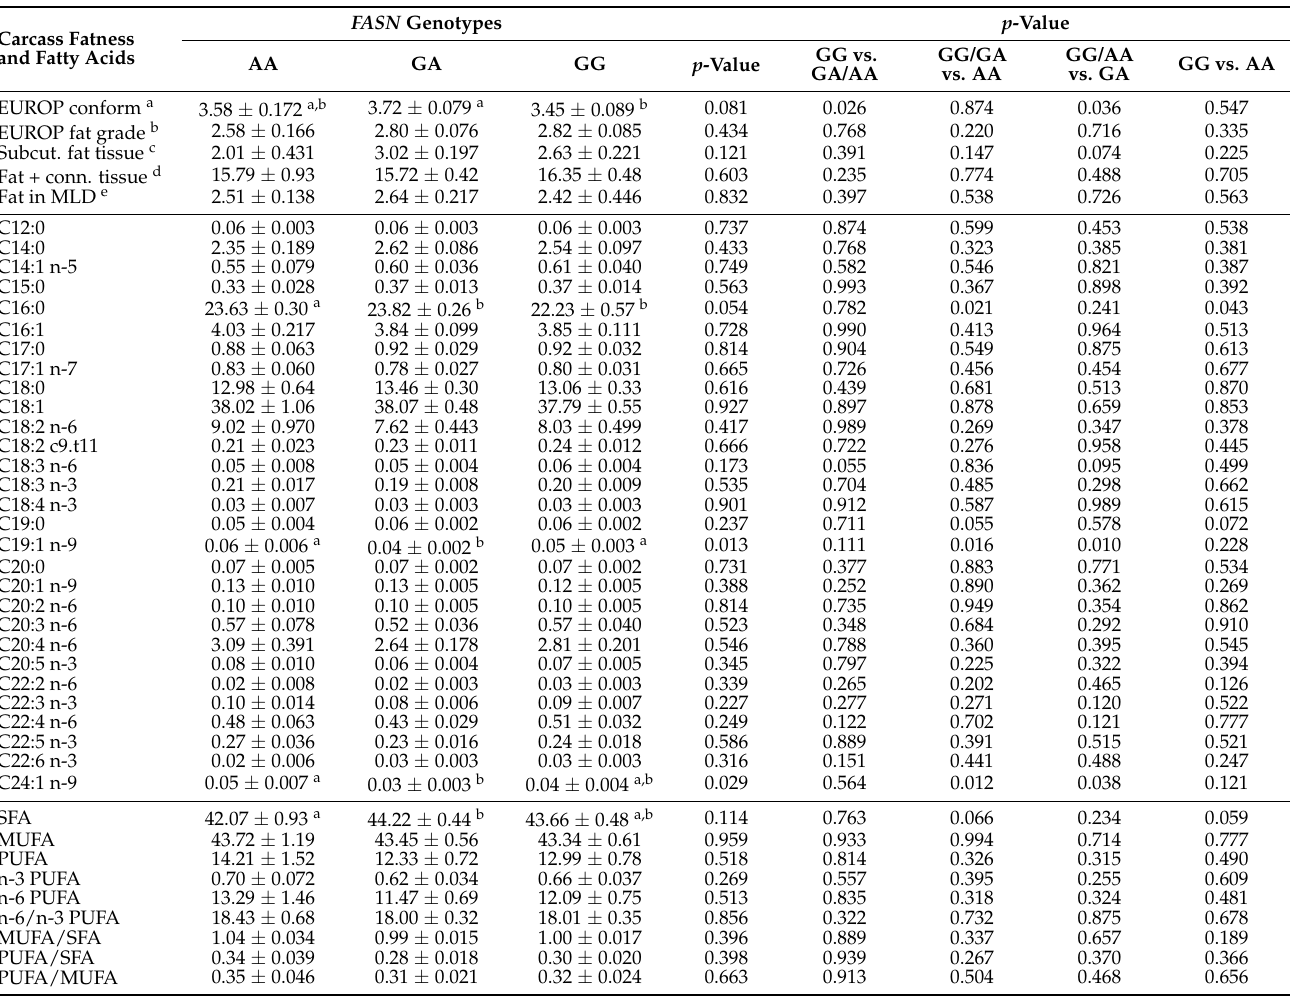
(Table 3). The AA genotype of the FASN gene had the lowest EUROP fat grade and subcuta- neous adipose tissue thickness (2.58; 2.21 cm; Table 3). Different combinations of genotypes had minor significant effects on carcass fatness and fatty acid composition of intramuscular lipids. For example, GG genotype vs. GA/AA ( p = 0.026) and GA vs. GG/AA ( p = 0.036) had a significant effect on EUROP conformation. Table 3. Carcass fatness and fatty acid content in MLD , their sums and ratio by FASN genotypes (LS Mean ± SE and p